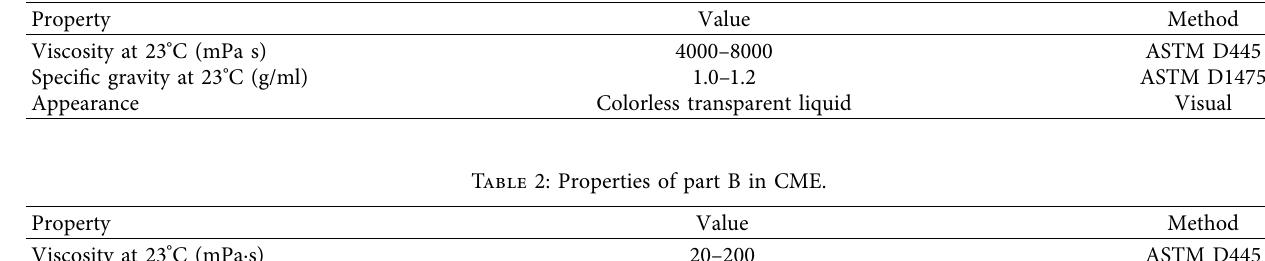
Table 1: Properties of part A in CME.